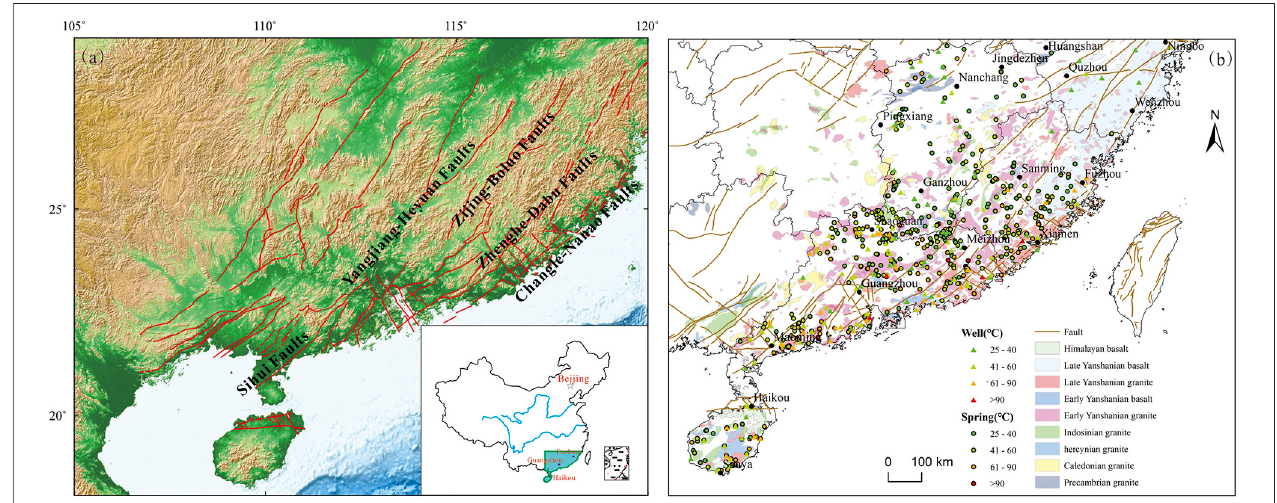
FIGURE 1 | Location of the study area and main faults (A) and hot springs in the igneous rock areas (B) .